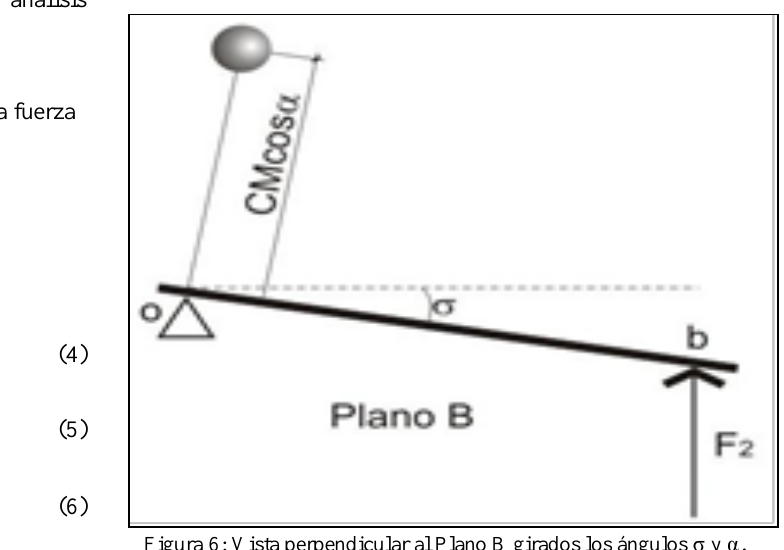
Figura 6: Vista perpendicular al Plano B girados los ángulos σ y α . Fuente: Autores,